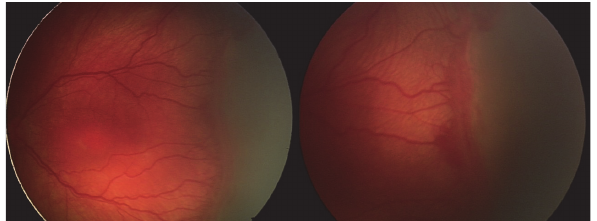
Fig. 1. Preoperative clinical findings of prematurely-born infant born in 25 th week of gestation, with a birth weight of 850 grams. Retinopathy of prematurity stage 3, zone II-III, plus disease. Images were taken in the 36 th week of PCA with the RetCam 3 digital imaging system.